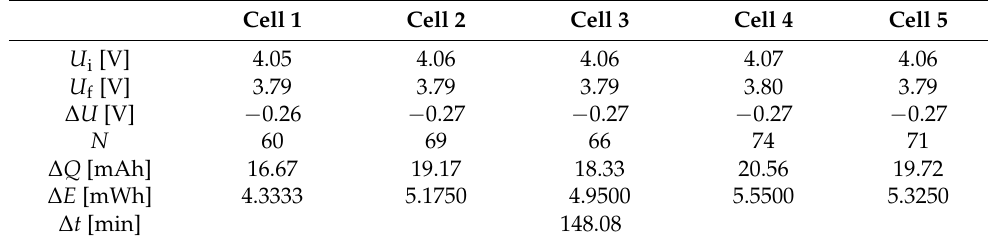
Table 7. Permanent storage system configuration